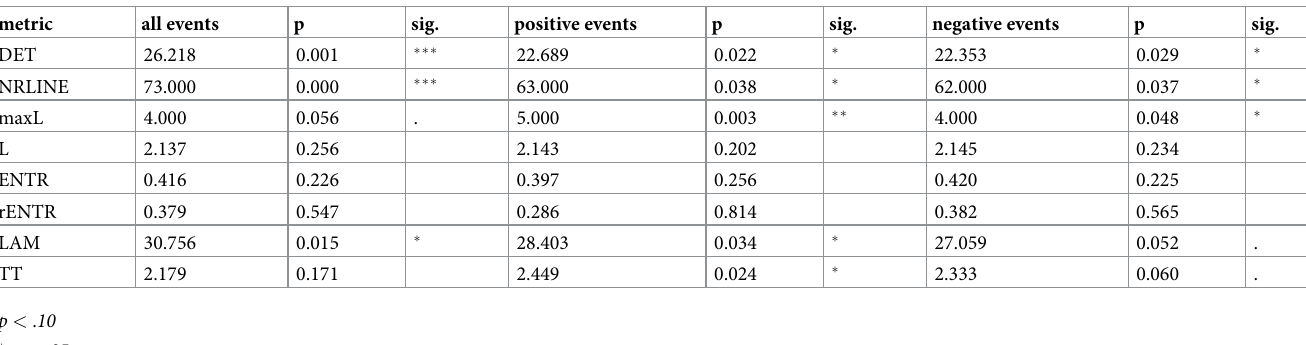
Table 1. CRQA results for target-only